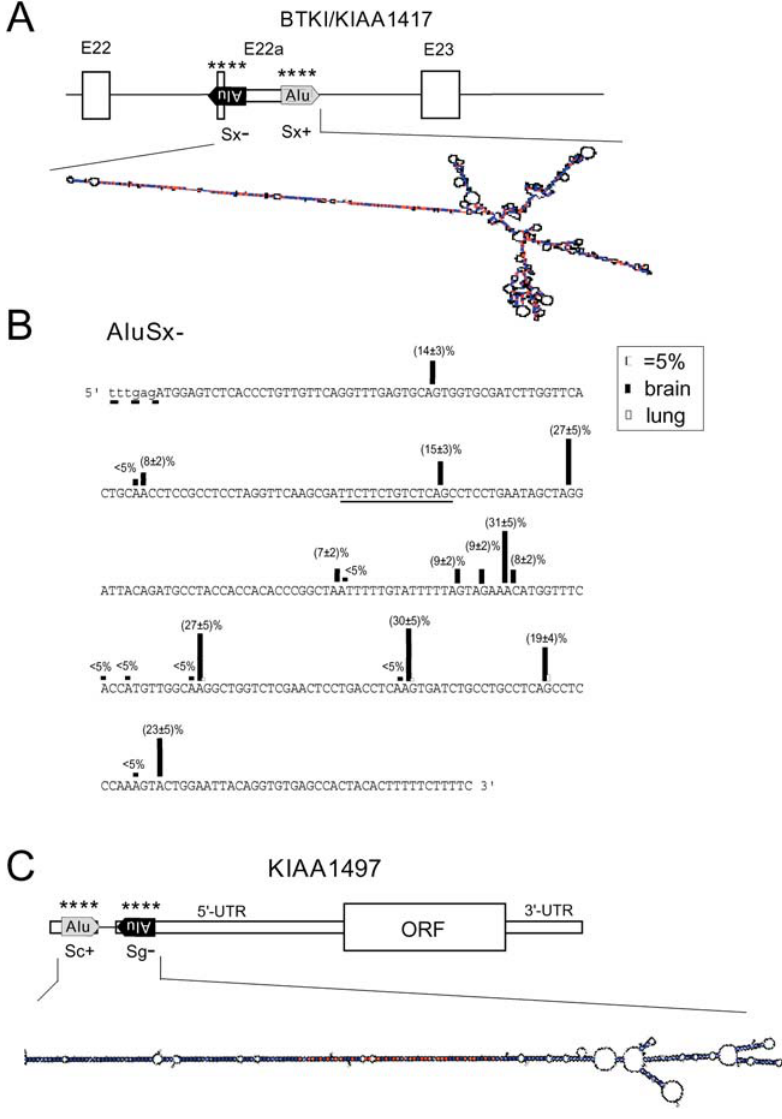
Figure 3. RNA Editing of Alternative Exon 22a in Inhibitor BTKI and the 5 9 -UTR of